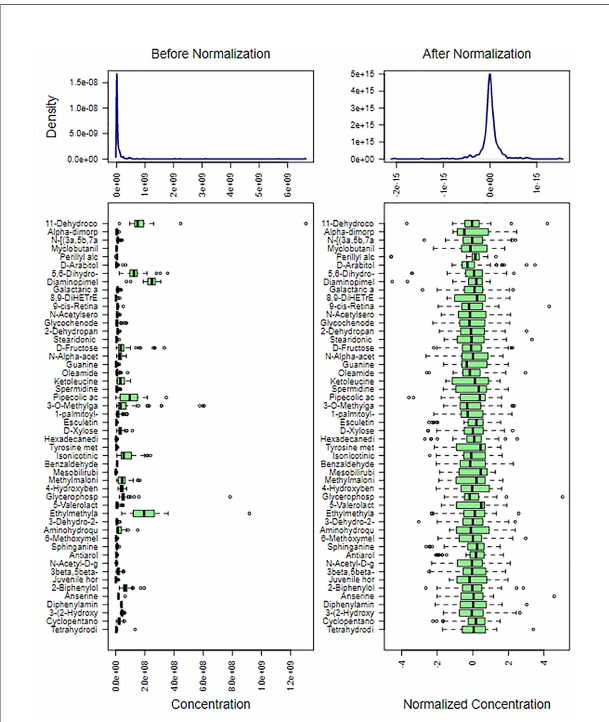
FIGURE 2 | Content distribution of each metabolite before and after normalization. The content distribution was represented by box plot, which was corresponded to outlier, minimum, lower quartile, median, upper quartile, maximum and outlier from left to right. The fi gure on the left shows the distribution before normalization, and the fi gure on the right shows the distribution after normalization.